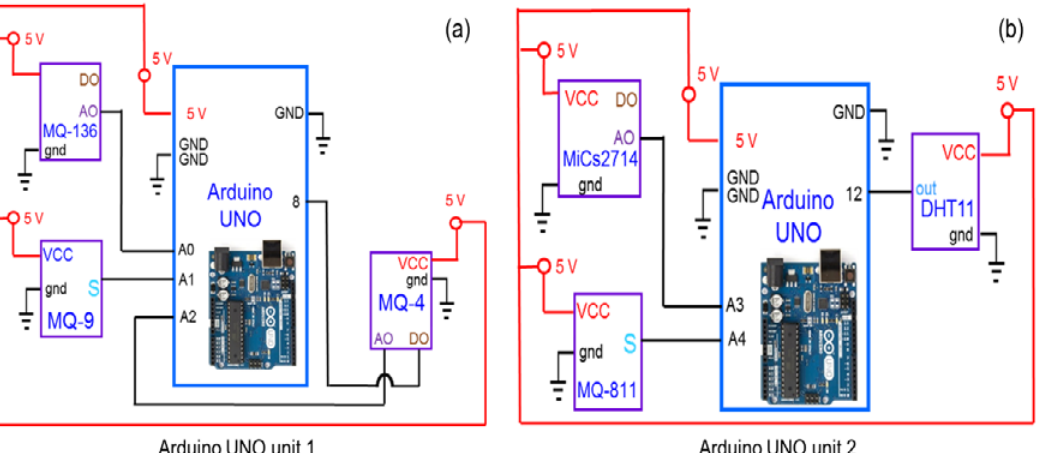
Figure 2. Circuit diagram of each sensor modules attached to the Arduino UNO based sensor nodes (SN) ( a ) attached MQ4, MQ136, and MQ9, ( b ) attached MiCs2714, MQ-811, and DTH11. Table 1. Sensors used for experimentation and their characteristics .